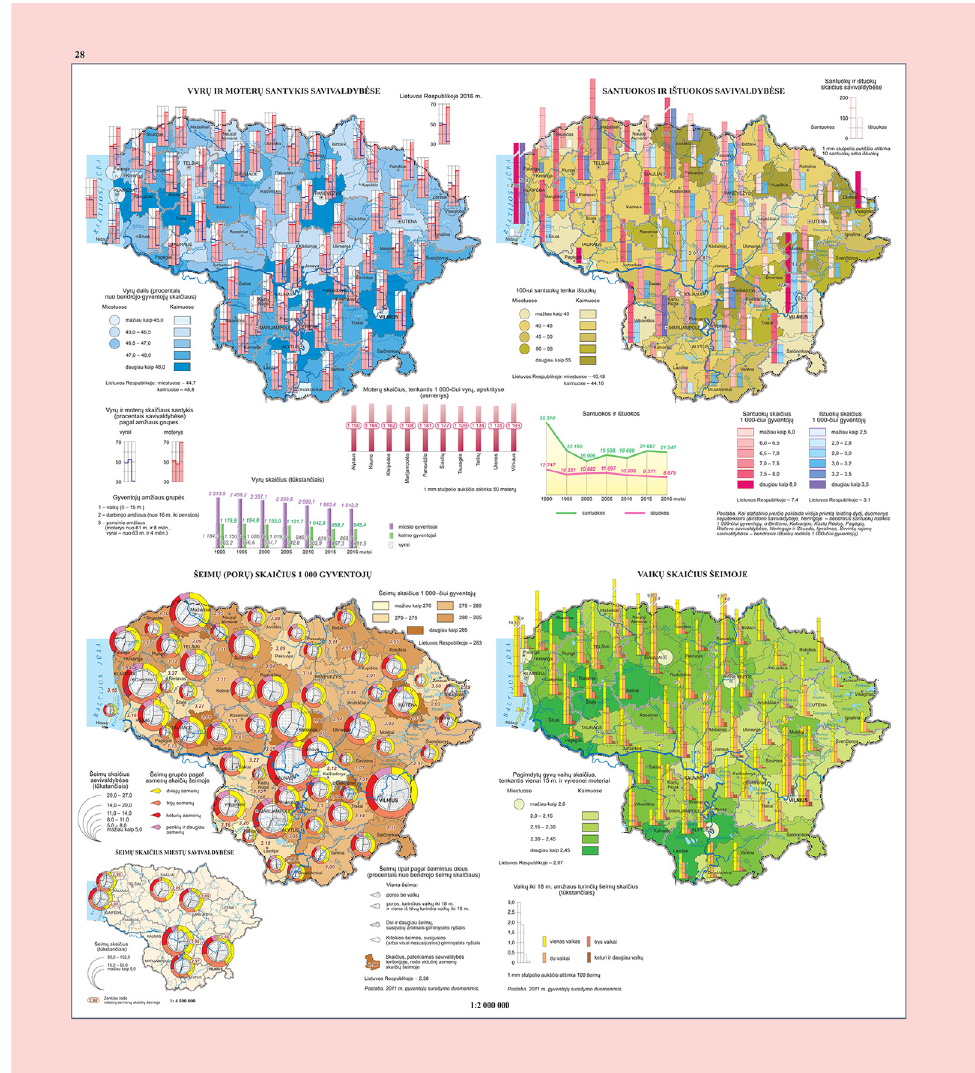
Fig. 3. Proportion of men and women, marriages and divorces, number of families, and number of children in families (reduced – original scale